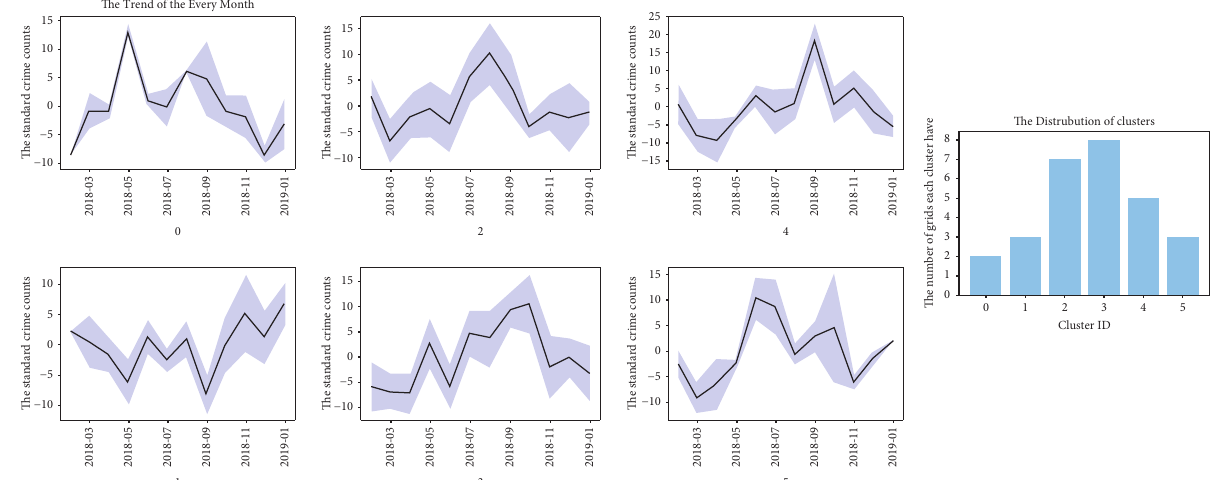
Figure 3: Chicago 2018 burglary monthly trends and distribution of the clusters. The line charts are the monthly trends of burglary in Chicago in 2018. The bar chart is the distribution of the